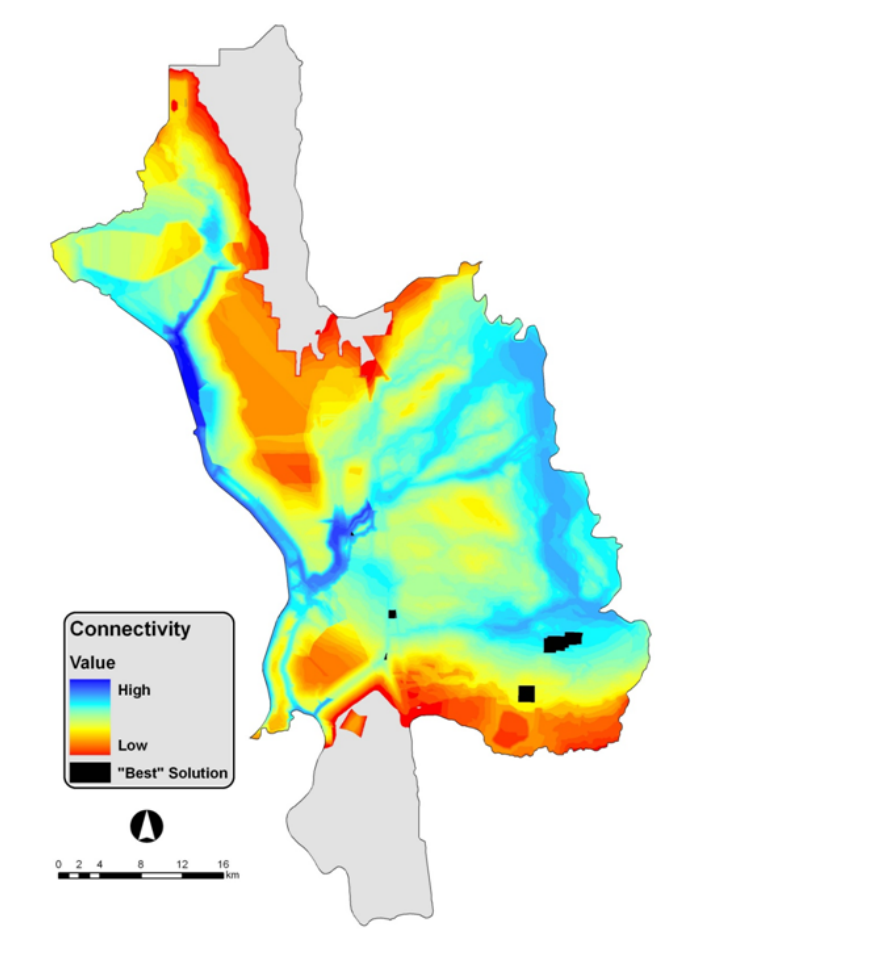
Fig. 7. The same potential mitigation solution from MARXAN shown overlaying the connectivity modeling surface for the Pleasant Grove study area. Acquisition of this set of parcels could contribute to maintaining and restoring some landscape connectivity. With the exception of the square parcel in the southeast, all of these parcels lie on modeled least-cost